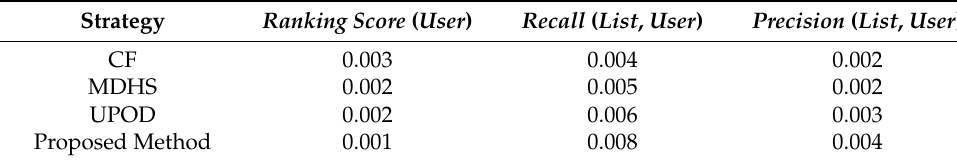
Table 10. Performance comparison based on σ